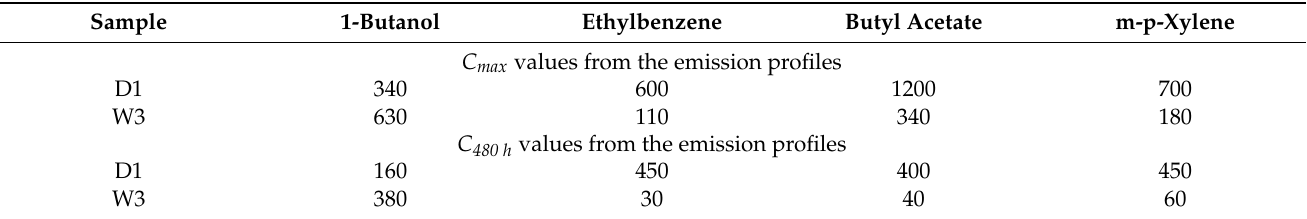
Table 9. Comparing the C max ( µ g/m 3 ) and C 480 h observed from the emission profiles of the four selected VOCs emitted from samples D1 tested in t = 29 ◦ C and samples W3 tested in t = 33 ◦ C (ACH n = 1.0 h − 1 ).